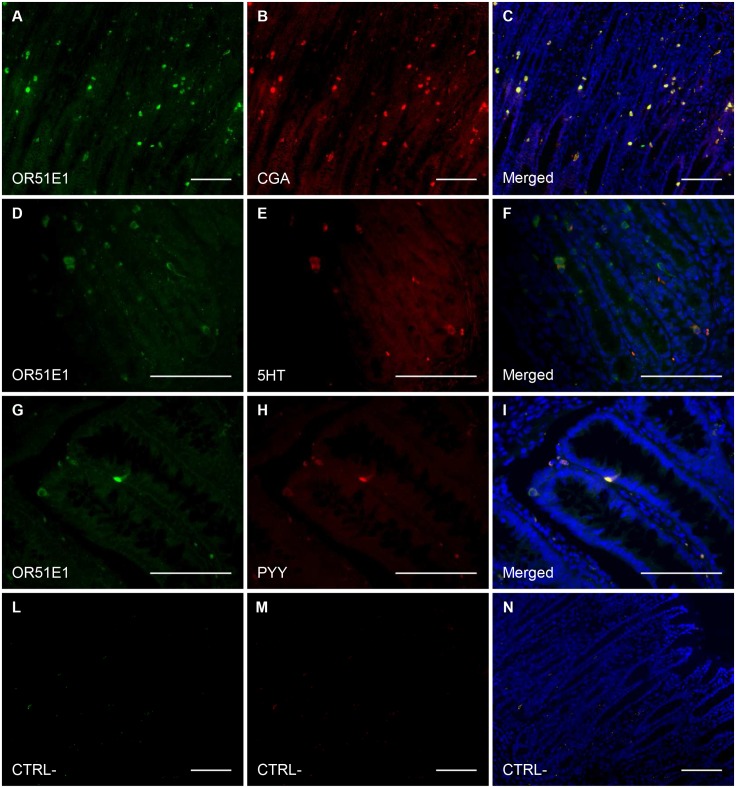
Visualization of OR51E1 co-localization with enteroendocrine cells and some hormones.A–F = pylorus, G-I = colon, L–N = pylorus, control (without primary antibodies). Scale bars = 100 μm. Almost all the OR51E1+ cells have an overlapping staining with the cells positive for the enteroendocrine marker chromogranin A (A, B, merged in C) showing the endocrine nature of these cells. A subset of these cells also contain hormones such as serotonin (C, D, merged in E) and peptide YY (G, H, merged in I) suggesting a possible role for OR51E1 in the control of hormone release. In control images only erythrocytes showed an auto-fluorescence.